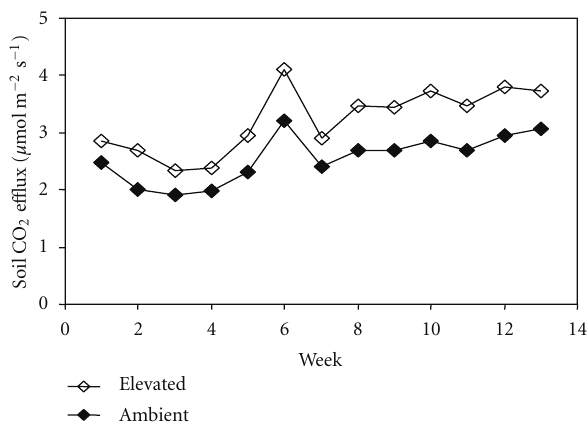
Figure 1: Weekly average soil CO 2 e ffl ux ( µ mol CO 2 m − 2 s − 1 ) for ambient (365 µ mol mol − 1 ) and elevated (720 µ mol mol − 1 ) CO 2 plots in a model regenerating longleaf pine-wiregrass ecosystem.